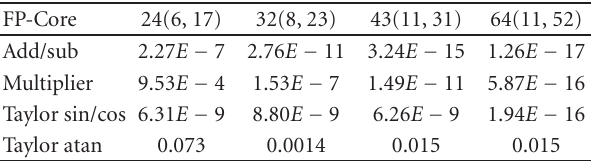
Table 2: MSE of the floating-point operators.